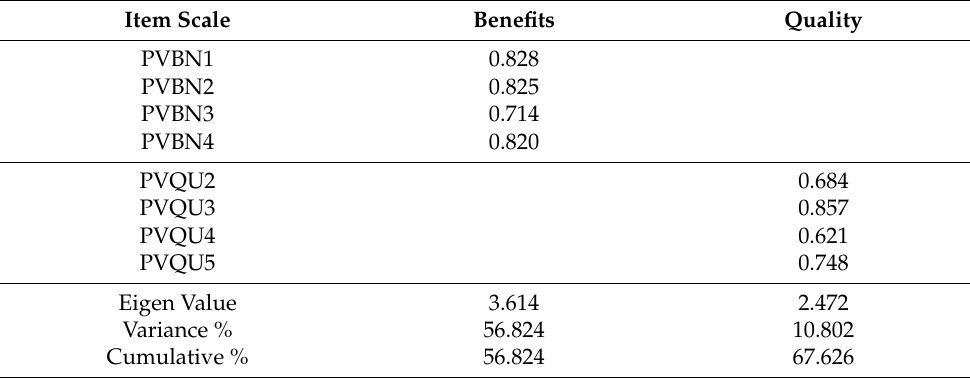
Table 3. Exploratory factor analysis for perceived value.